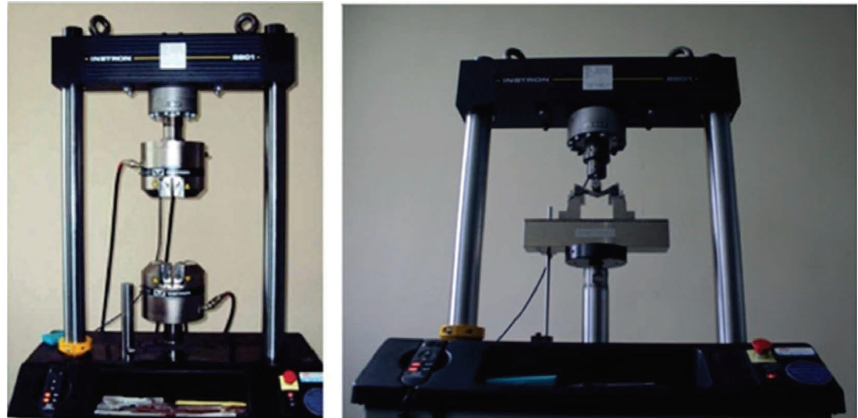
Figure 6: Instron universal testing machine.